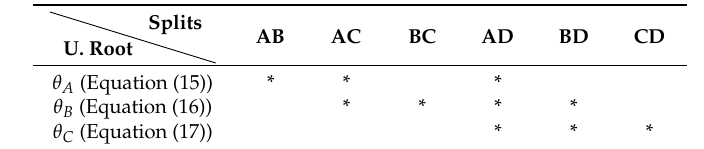
Table 2. Active roots (indicated by *) during different splits for separation of four components ABCD (from Figure